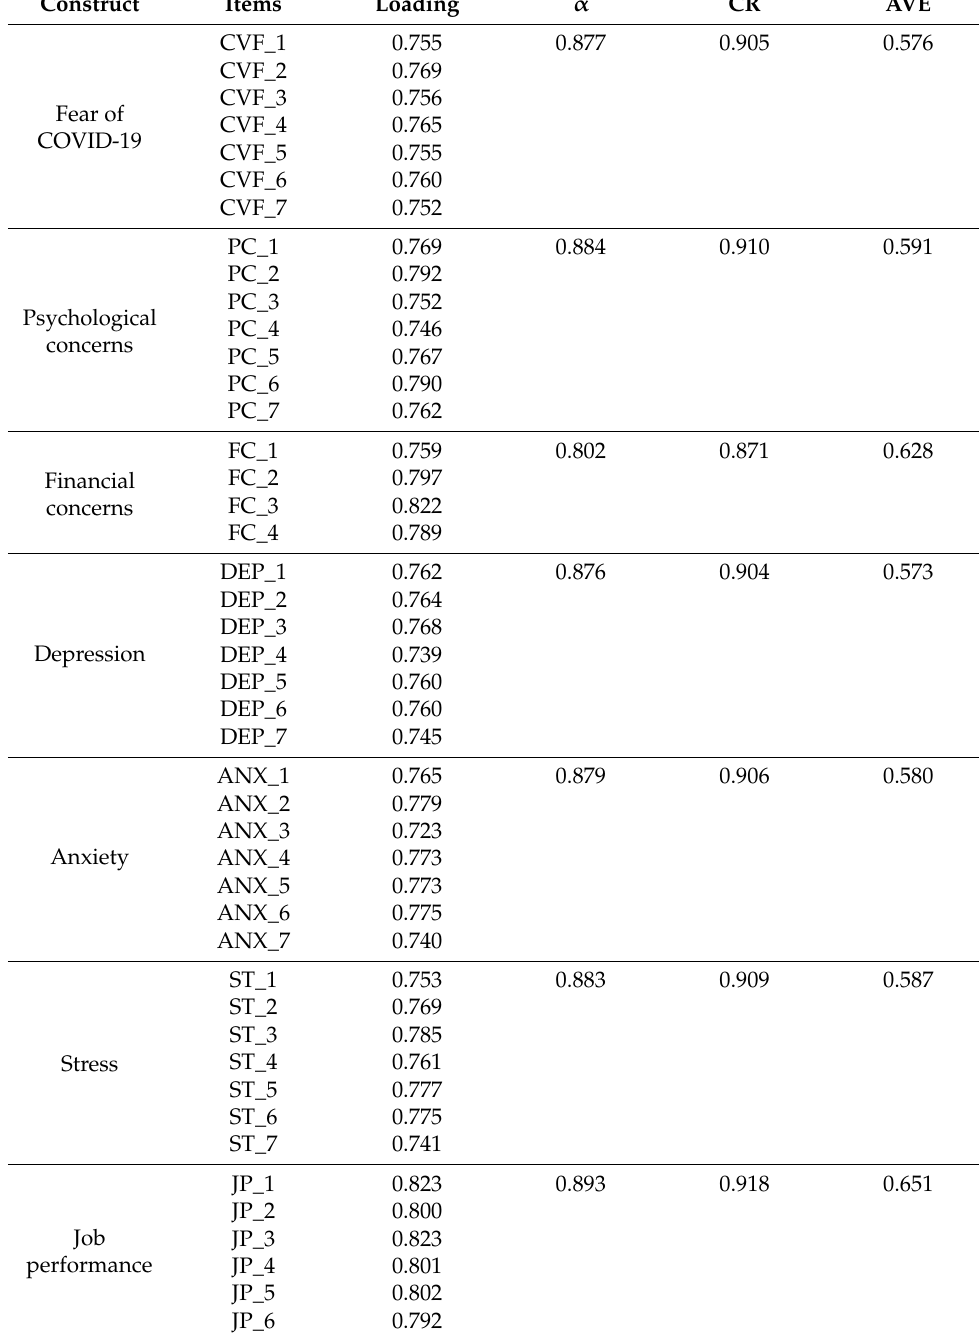
Table 3. Reliability and Validity